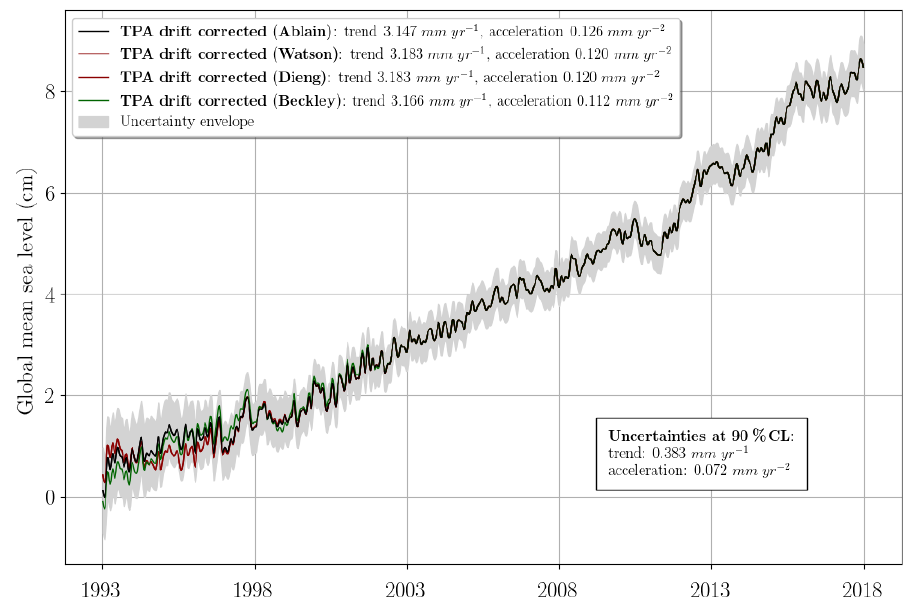
Figure 4. Evolution of the AVISO GMSL with different TOPEX-A corrections. On the black, red and green curves, the TOPEX-A drift correction has been, respectively, applied based on Ablain (2017), Watson et al. (2015), Dieng et al. (2017) and Beckley et al. (2017). The uncertainty envelope, as well as the trend and acceleration uncertainties, are given to a 90% confidence level (1 . 65 σ ). Seasonal (annual and semi-annual) signals removed and 6-month smoothing applied. A GIA correction of − 0 . 3mmyr − 1 has been subtracted from each data set. A correction of + 0 . 10mmyr − 1 due to the deformations of the ocean bottom in response to modern melt of land ice (Frederikse et al., 2017; Lickley et al., 2018) has also been